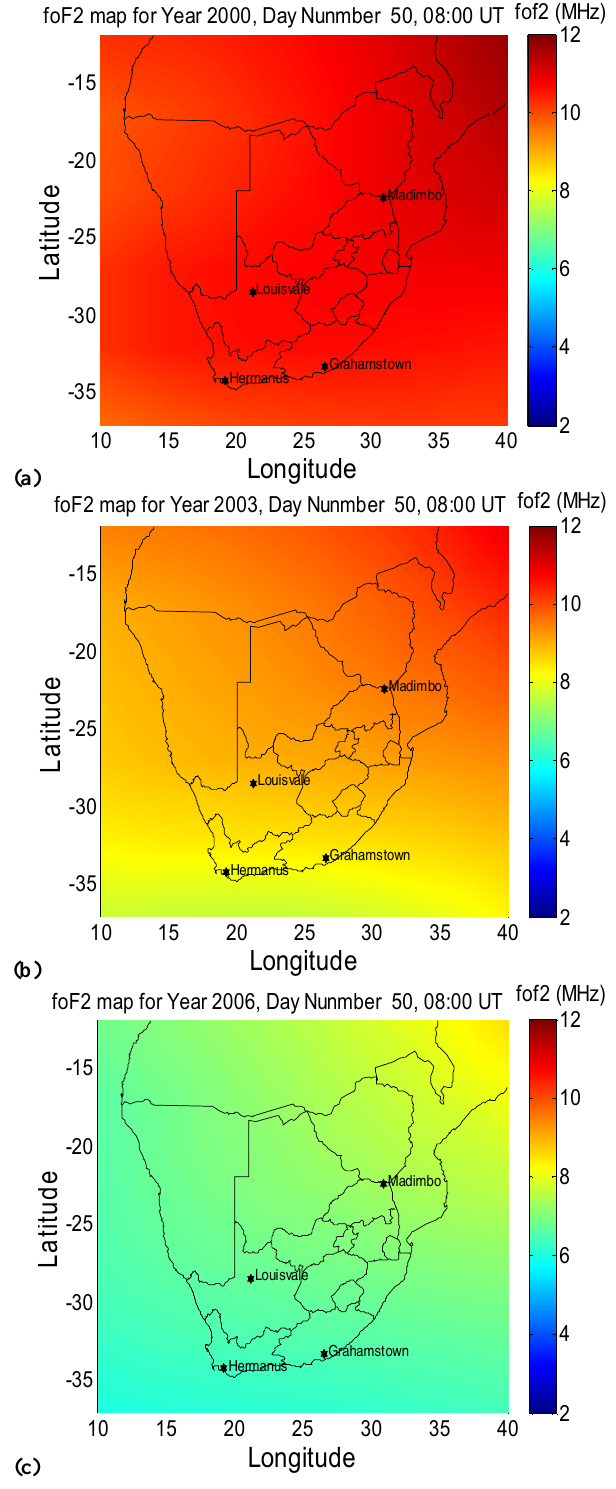
Fig. 5. Variations in fo F2 over South Africa for (a) a year of max- imum solar activity, (b) a year of moderate solar activity and (c) a year of minimum solar